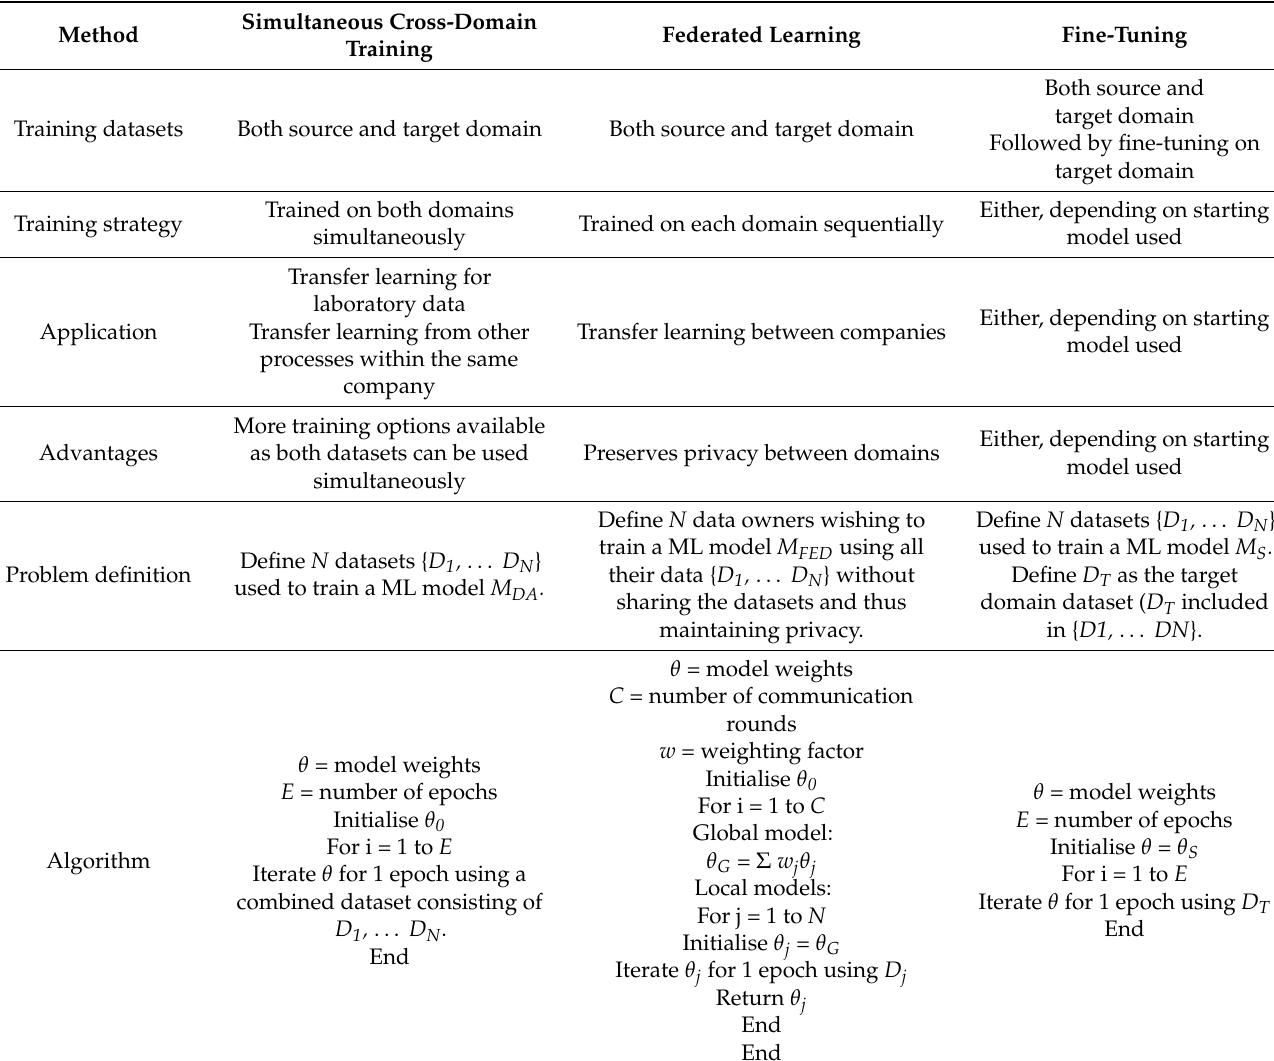
Table 1. Summary of the three domain adaptation machine learning methodologies